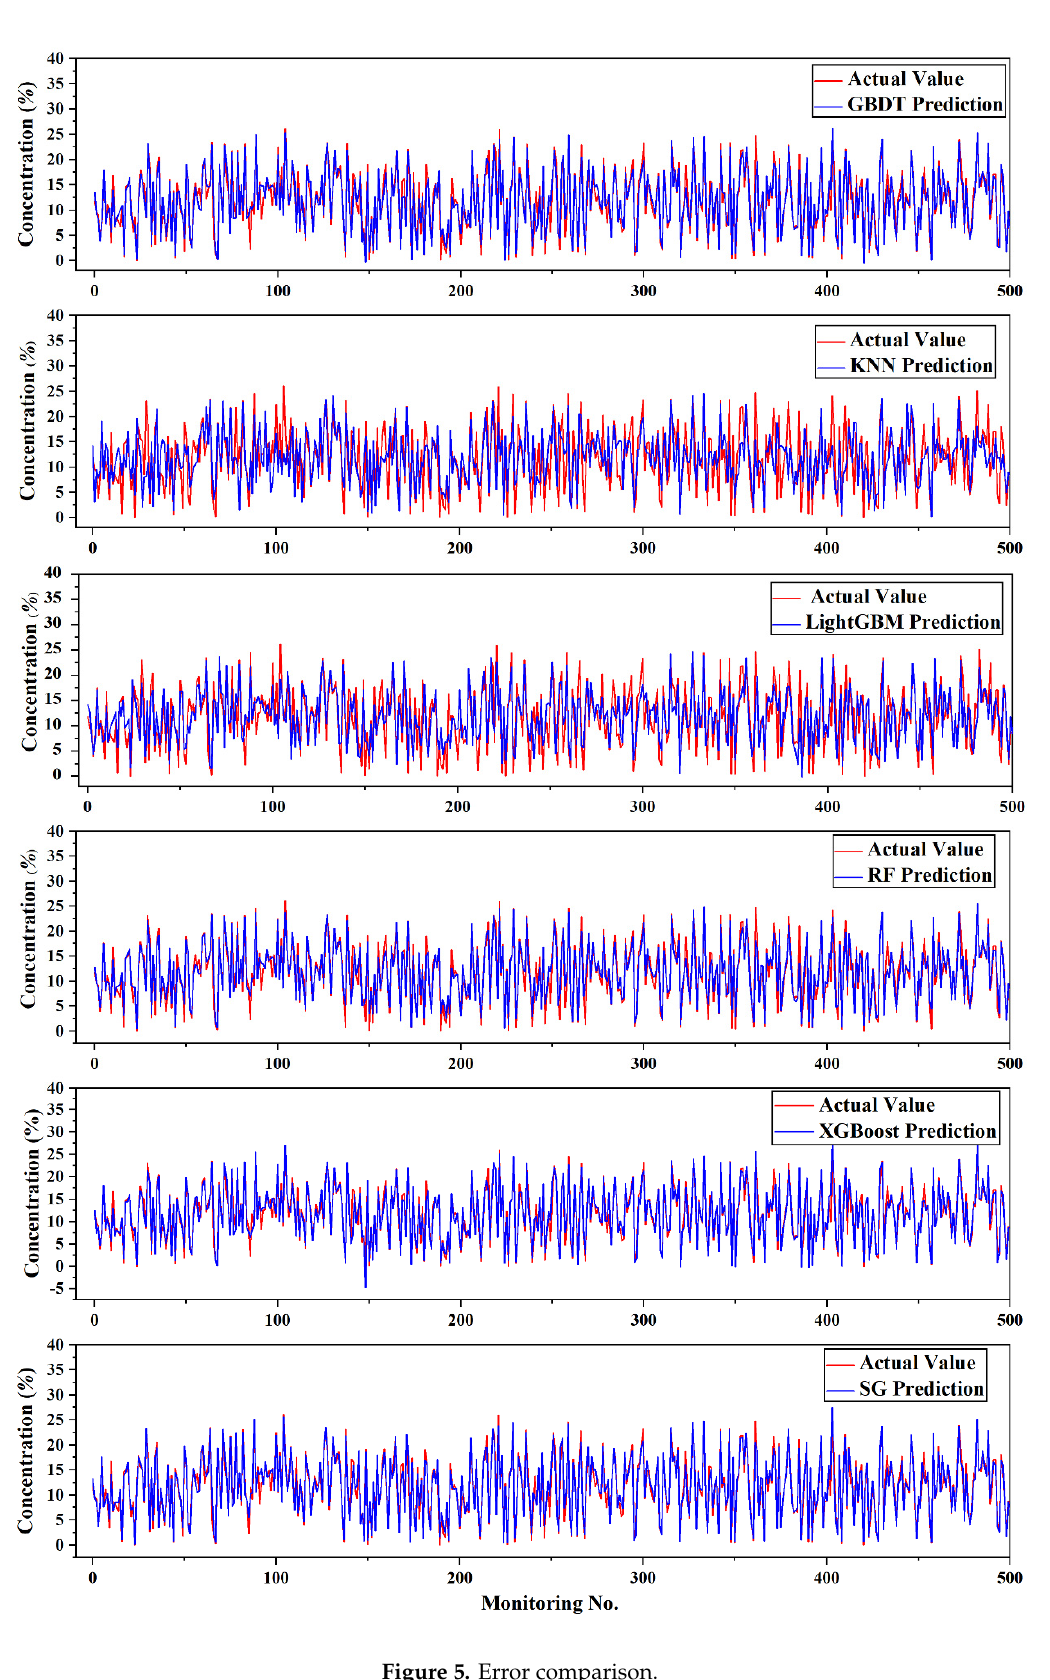
Figure 5. Error comparison.